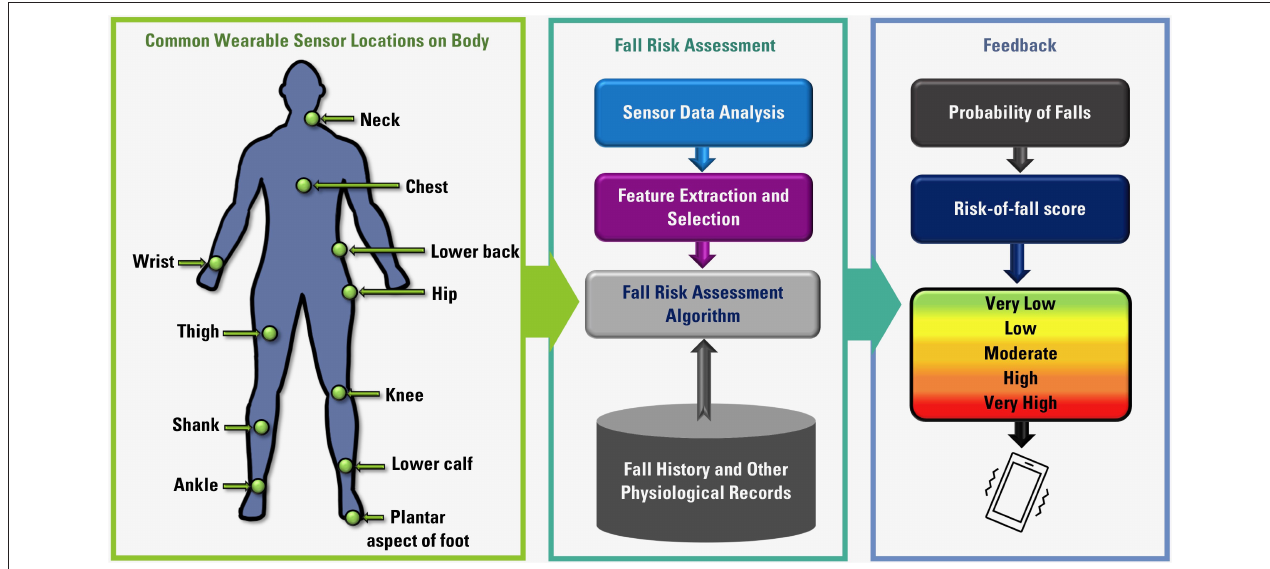
FIGURE 1 | Overall flow diagram of fall risk assessment using wearable